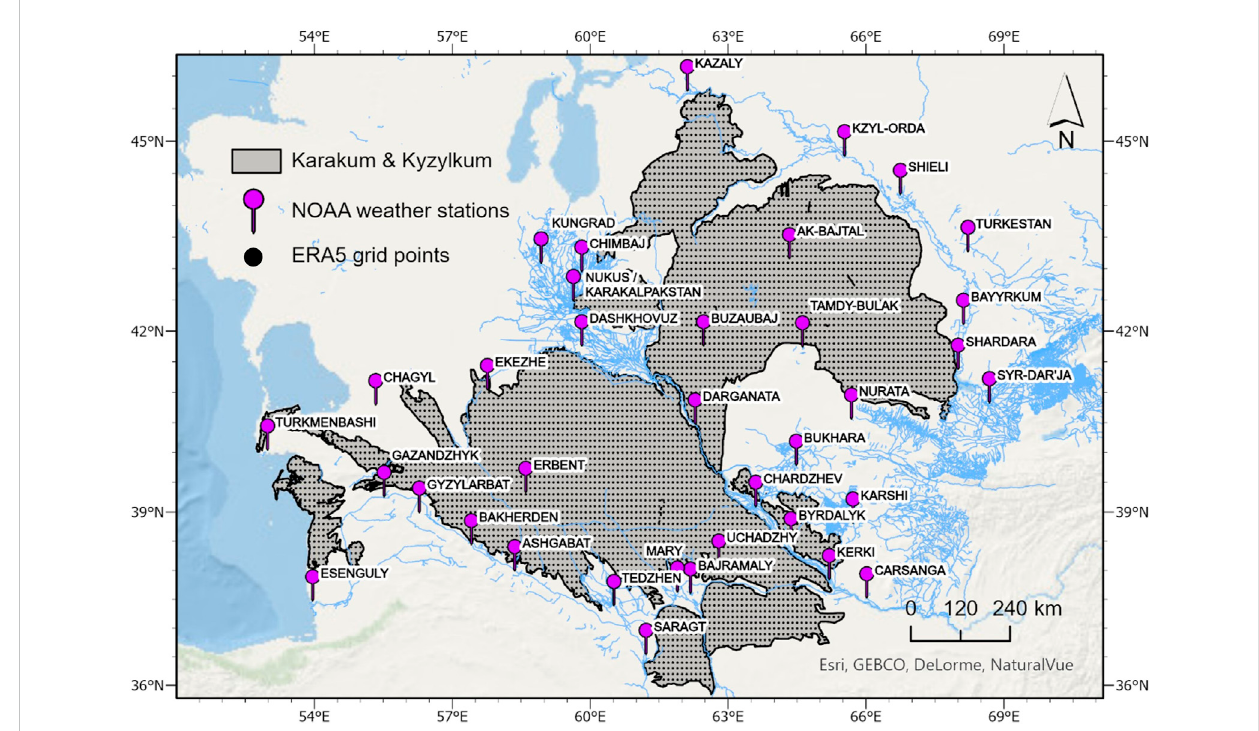
FIGURE 3 Spatial distribution ofthe36NOAA weatherstations within andsurroundingtheresearch areaand5081ERA5 gridcontrolpoints. Dataisavailableat National Oceanic and Atmospheric Administration (NOAA) web portal and the European Centre for Medium-Range Weather Forecasts (ECMWF) data server,